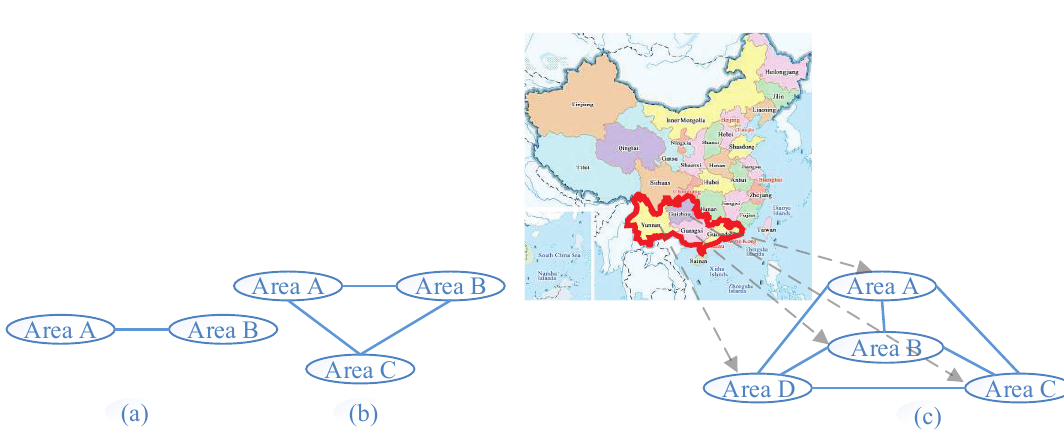
Figure 7. Topological graph of the three power systems: ( a ) Two-area power system; ( b ) Three-area power system; ( c ) China Southern Power Grid .